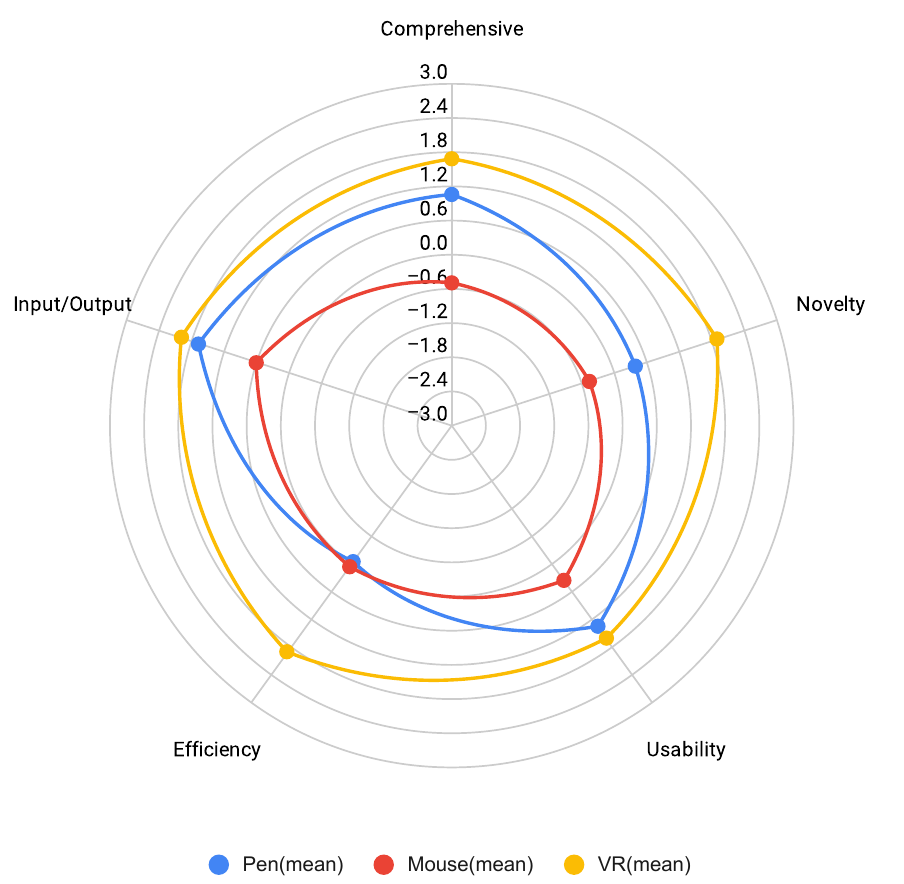
Figure 6. Statistical summary results of user experience survey scale (questionnaire) when using a traditional whiteboard (pen), electronic whiteboard (mouse), and the proposed VR